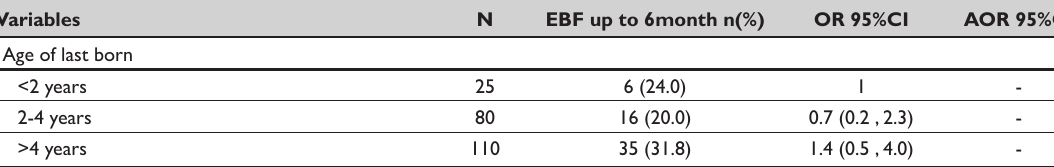
Table 5: Predictors of exclusive breastfeeding practices using 24 hours recall method among